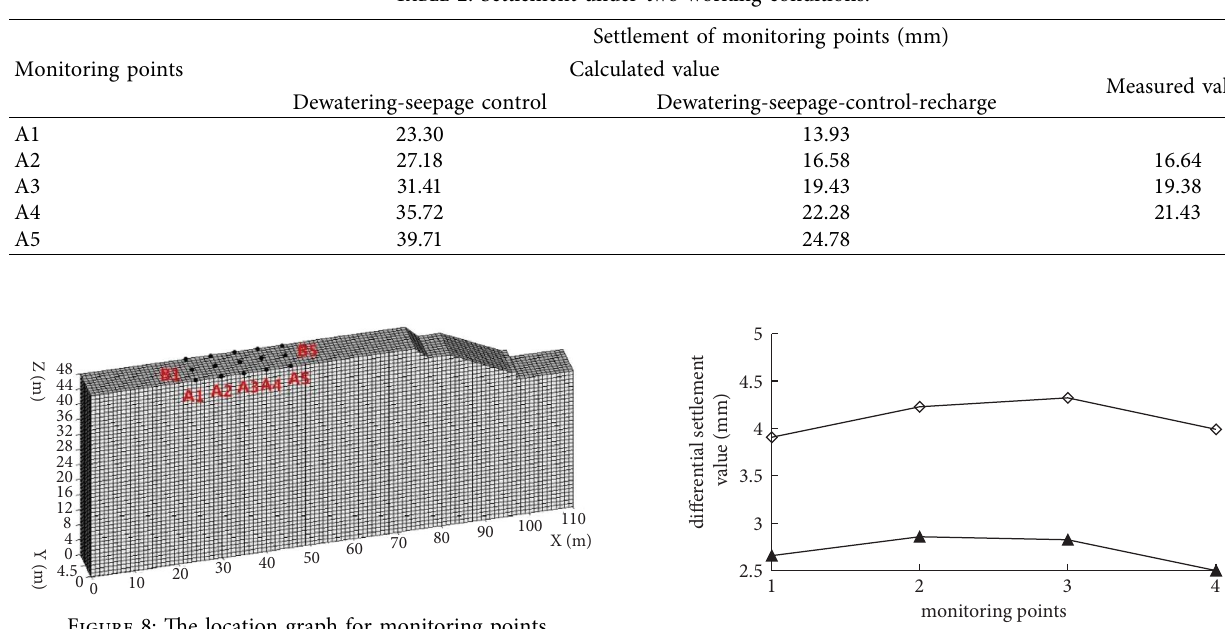
Table 2: Settlement under two working conditions.